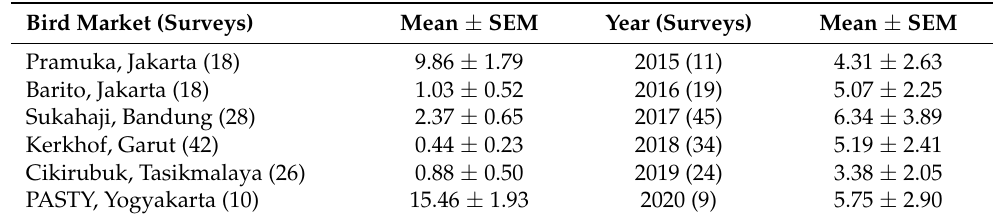
Table 3. Number (mean ± SEM) of strawheaded bulbuls Pycnonotus zeylandicus observed in six wildlife markets in Java, Indonesia. The mean number of birds observed by year is calculated by giving equal weight to each wildlife